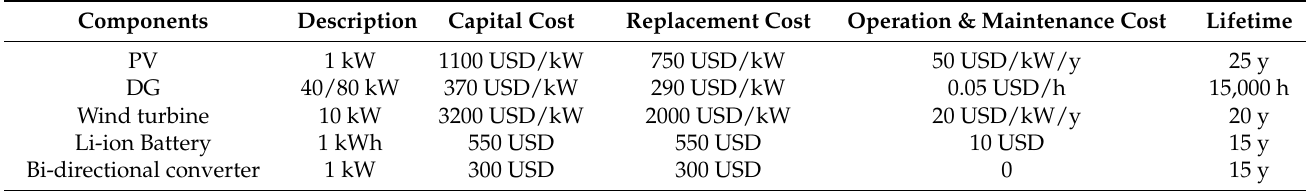
Table 2. Cost of Installed Components